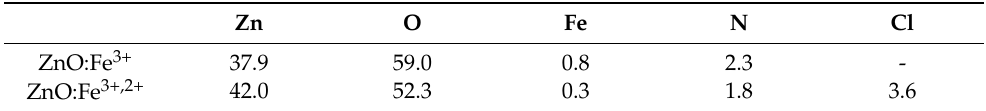
Table 2. X-ray photoelectron spectroscopy (XPS) measured elemental composition of ZnO:Fe 3+ and ZnO:Fe 3+,2+ samples. Concentrations given in atomic %.